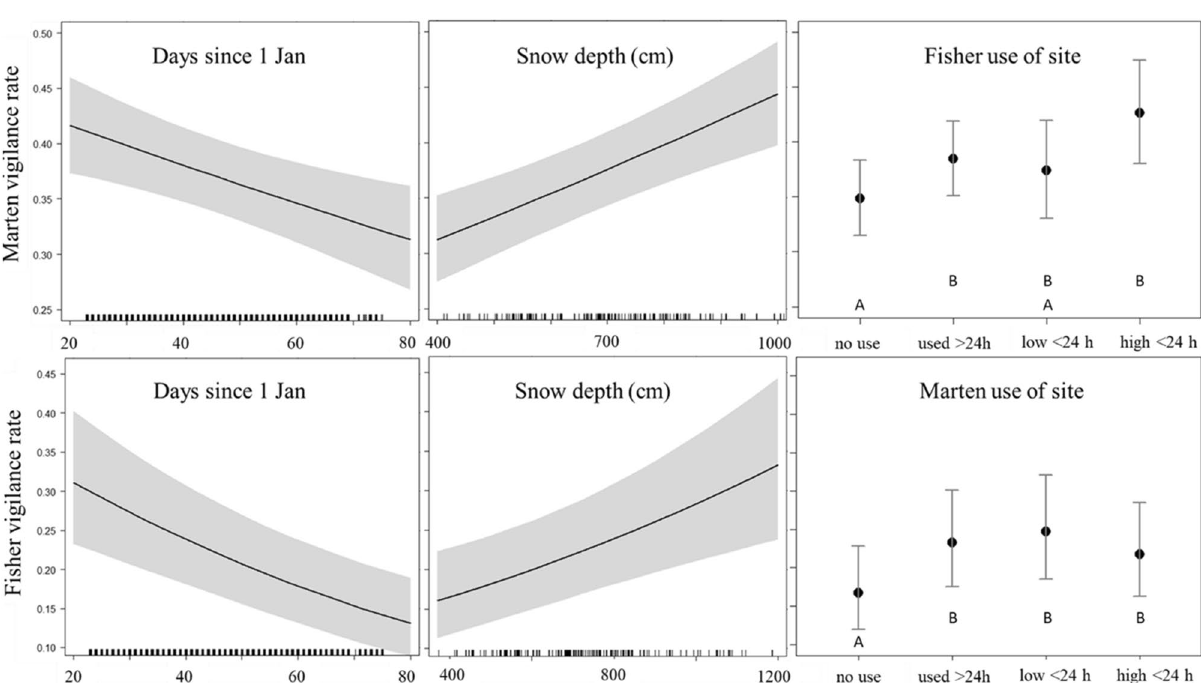
Figure 3. Logistic regression effect estimates with 95% confidence intervals for factors influencing probability of vigilance behavior for American marten (top row) and fisher (bottom row), Upper Peninsula of Michigan, USA, January–March 2017–2019. Interspecific site use classifications (right column) include: “no use” as sites with no previous observations of the other species within the winter, “used > 24 h” as sites with the other species previously observed but not within the previous 24 h, “Low < 24 h” as sites with median or less image counts of the other species within the previous 24 h, and “high < 24 h” as sites with greater than median image counts of the other species within the previous 24 h. Letters represent statistically different estimates ( P <